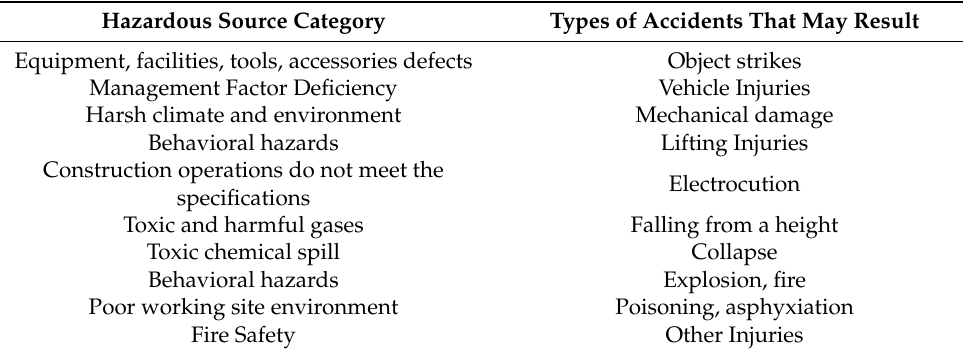
Table 2. Classification of hazard source information